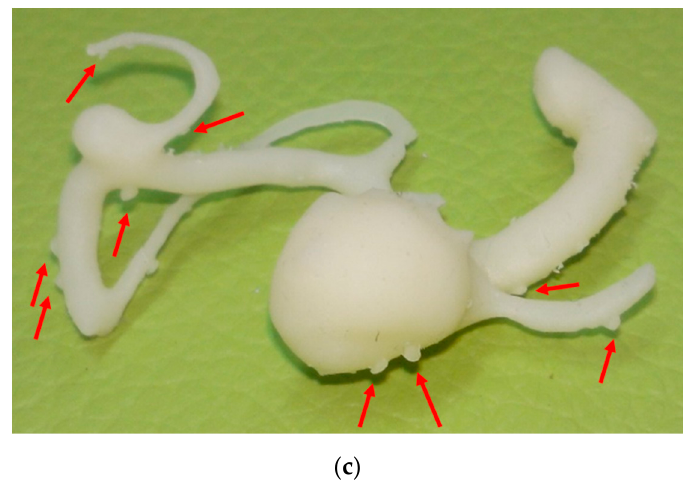
Figure 6. Patient #3 aneurysms reproduction and printing: ( a ) 3D reconstruction of DSA showing the L-ICA (light blue) and the L-MCA (light green) aneurysms; ( b ) 3D printed model showing the support structure before removal; ( c ) 3D printed model after the removal of the support structures (the red arrows indicate the positions of the supporting pins).